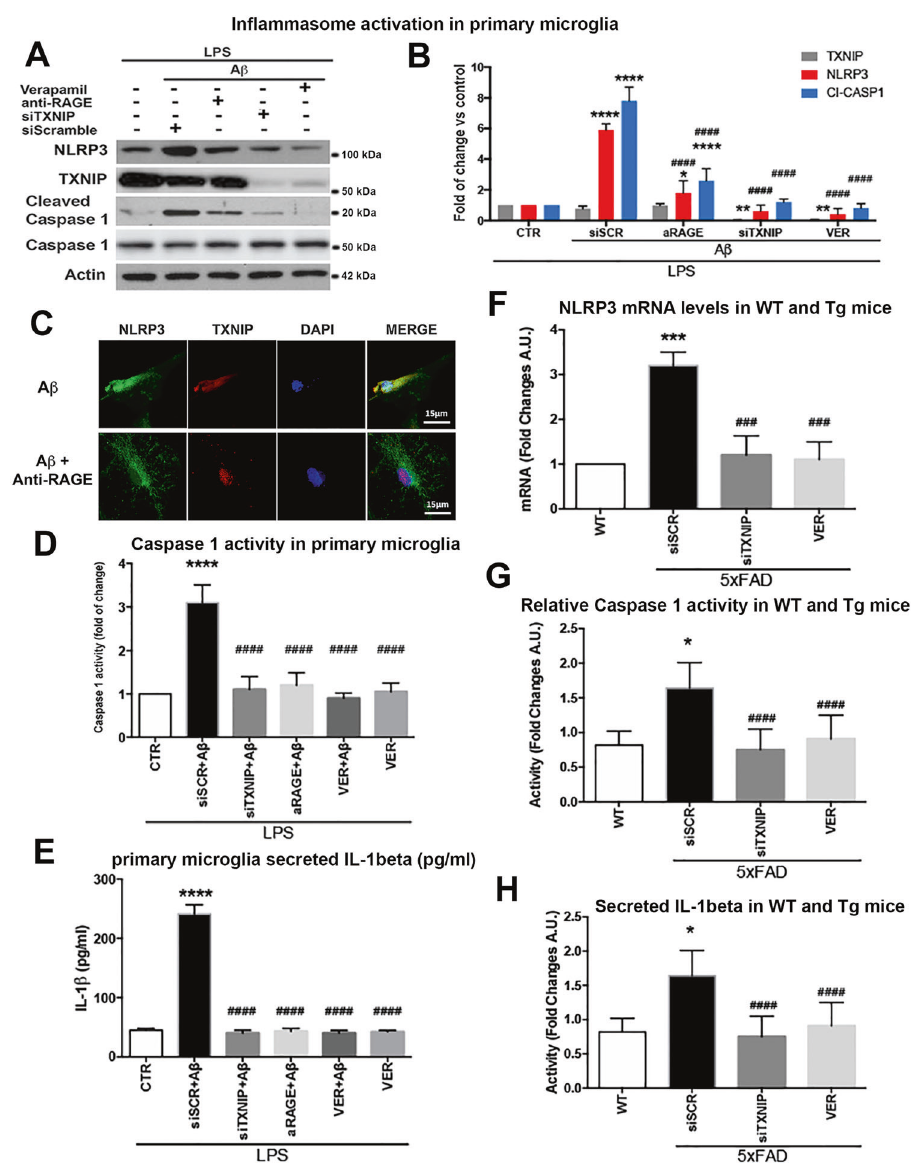
Fig. 5 RAGE – TXNIP axis is implicated in A β -induced NLRPS in fl ammasome activation. A , B Western blot analysis ( A ) and quanti fi cation ( B ) of TXNIP, NLRP3, cleaved caspase-1 one-way ANOVA followed by Tukey ’ s multiple comparison test ( n = 5; * p < 0.05, ** p < 0.01, **** p < 0.0001 versus control; #### p < 0.0001 versus siScramble). Actin was used as loading control. C IF analysis of NLRP3 (green) and TXNIP (red), in microglia treated as indicated, nuclei are in blue (representative of n = 3). D Quanti fi cation of caspase-1 activity in microglia treated as indicated. One- way ANOVA followed by Tukey ’ s multiple comparison test ( n = 5; **** p < 0.0001 versus control; #### p < 0.0001 versus siScramble). E ELISA of secreted Il-1 β from the medium of microglia treated as indicated. One-way ANOVA followed by Tukey ’ s multiple comparison test ( n = 6; of caspase-1 activity in wt and 5xFAD hippocampus of mice treated as indicated. One-way ANOVA followed by Tukey ’ s multiple comparison test ( n = 4; * p < 0.05 versus control; #### p < 0.0001 versus siScramble). H ELISA of secreted IL-1 β in wt and 5xFAD hippocampus of mice treated as indicated. One-way ANOVA followed by Tukey ’ s multiple comparison test ( n = 4; p < 0.05 versus control; #### p < 0.0001 versus